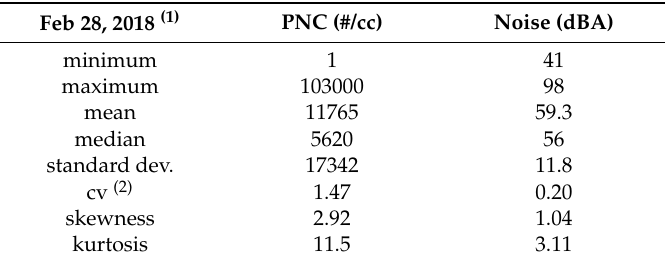
Table 1. Descriptive statistics for participant #